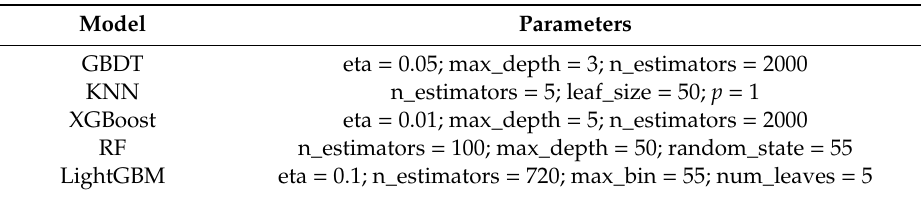
Table 5. Parameters of the five